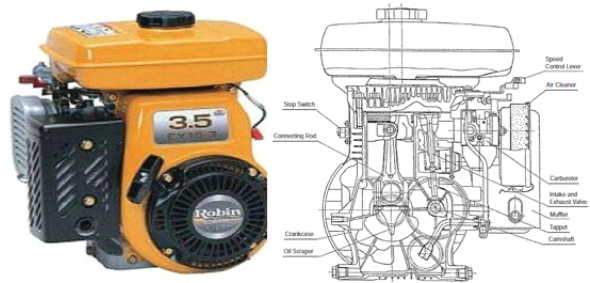
Figure 1: Exterior image and schematic representation of the engine